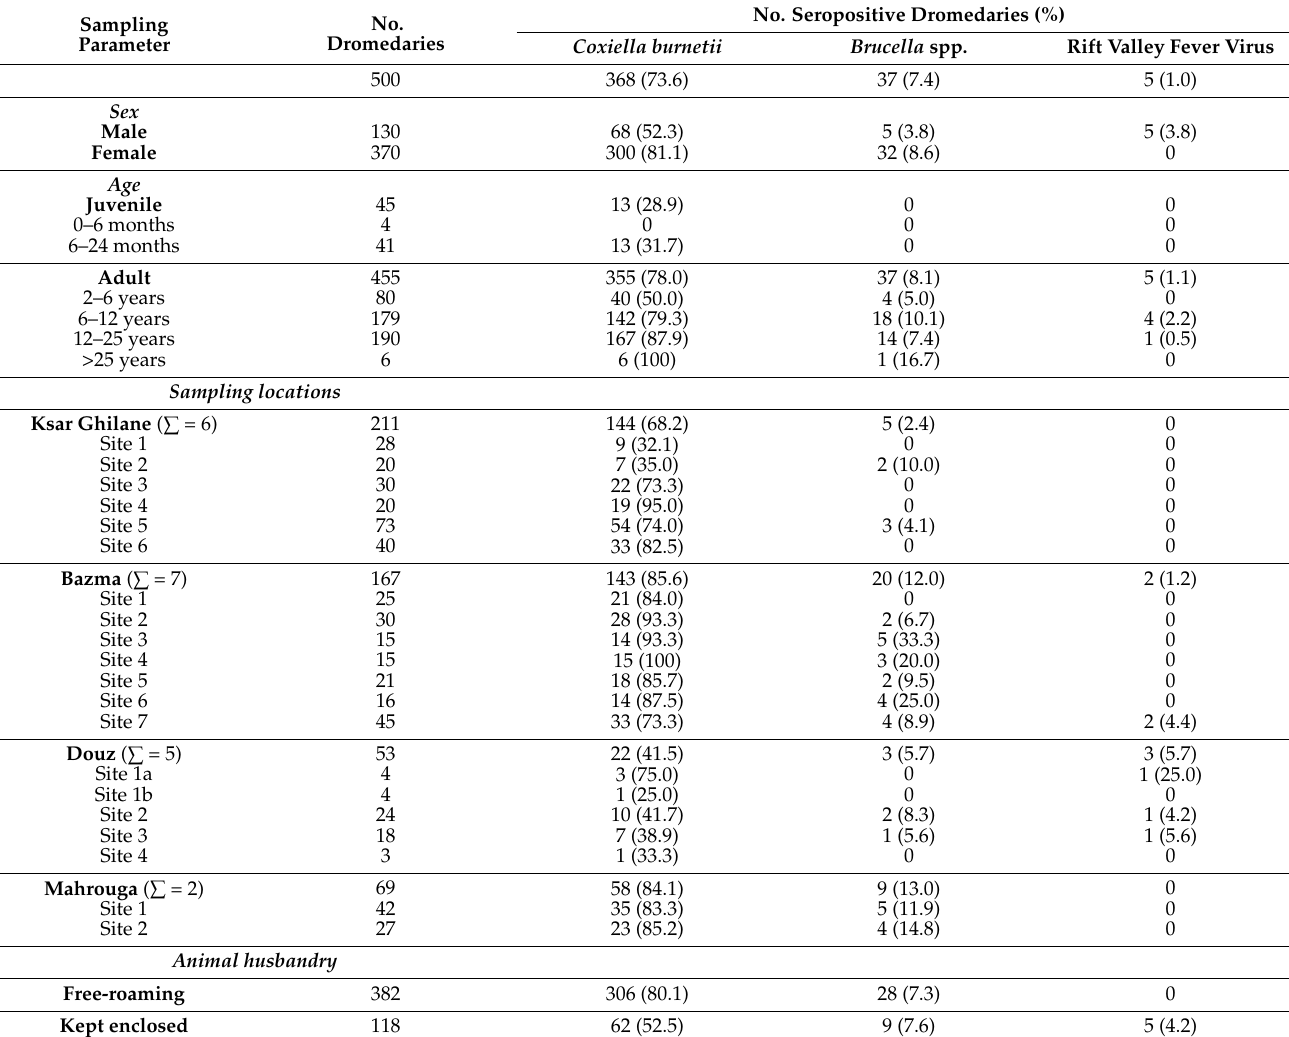
Table 1. Seropositive dromedary camels by zoonotic diseases and different sampling parameters. Gray shaded lines: Male animals kept enclosed for transport and patrol